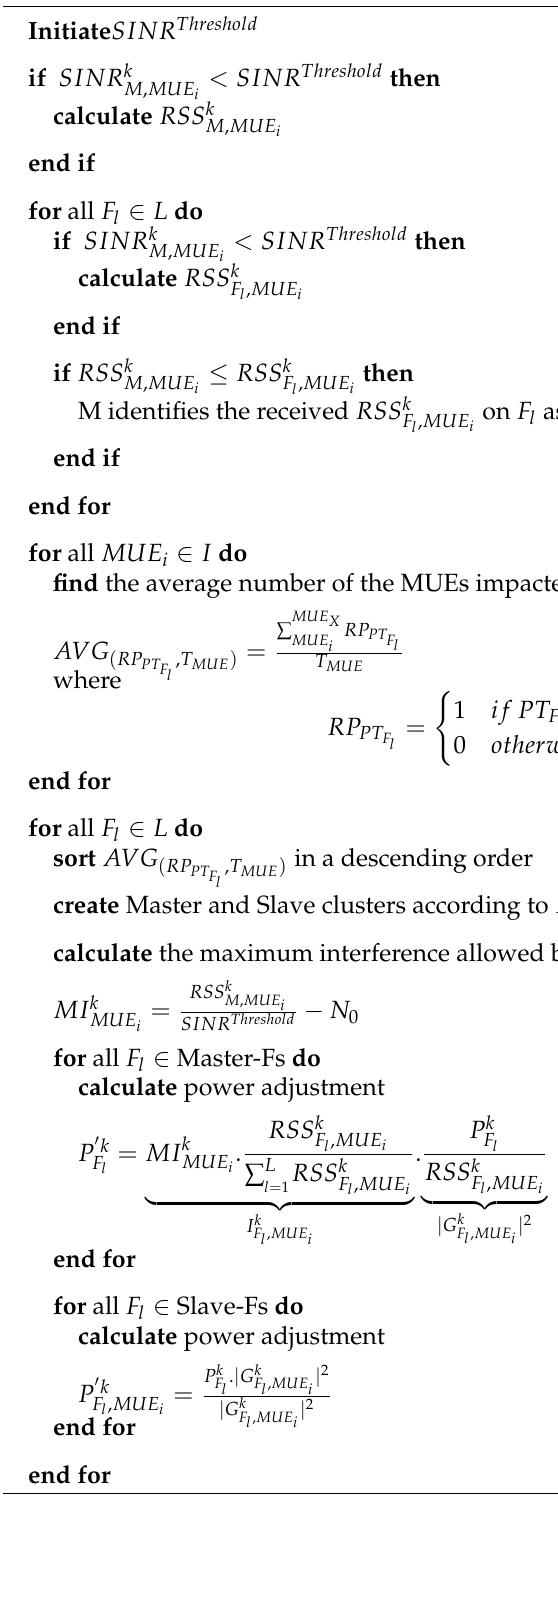
Algorithm 1 Hybrid Power